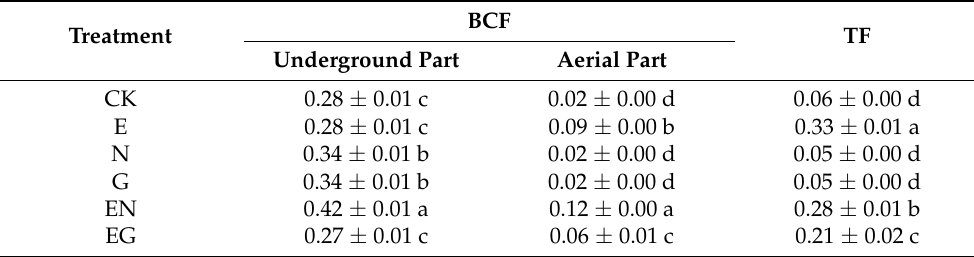
Table 2. Effects of different treatments on BCF and TF values of dwarf bamboo. All data are shown as the means ± SDs ( n = 3). Different lowercase letters indicate that the mean values are significantly different among the treatments according to Duncan’s multiple range test ( p < 0.05).